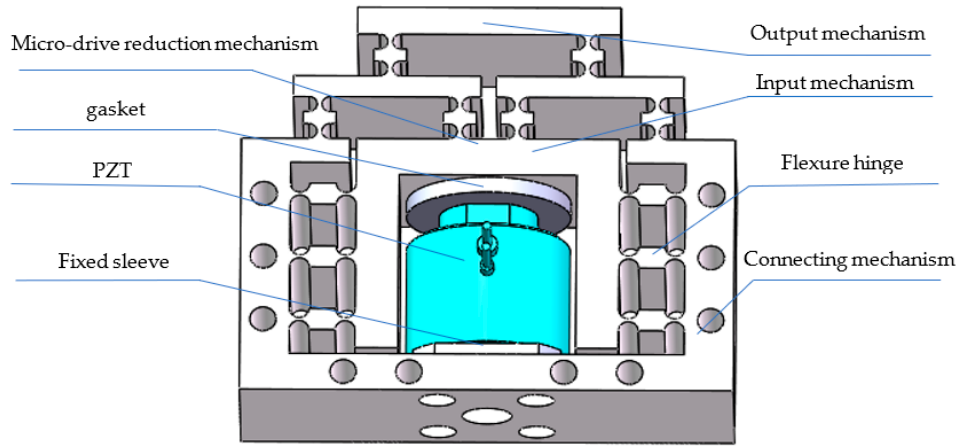
Figure 1. Structure diagram of the micro-drive reduction system.